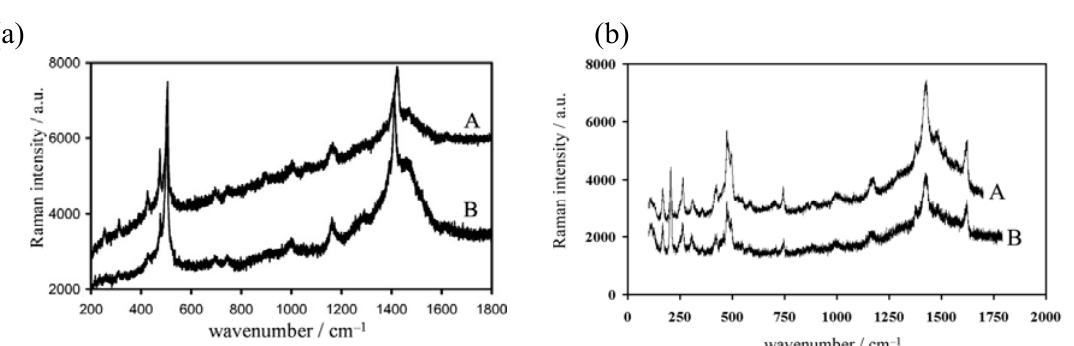
Figure 45. Raman spectra of nanowires or nanosticks (A) and single crystals (B) for